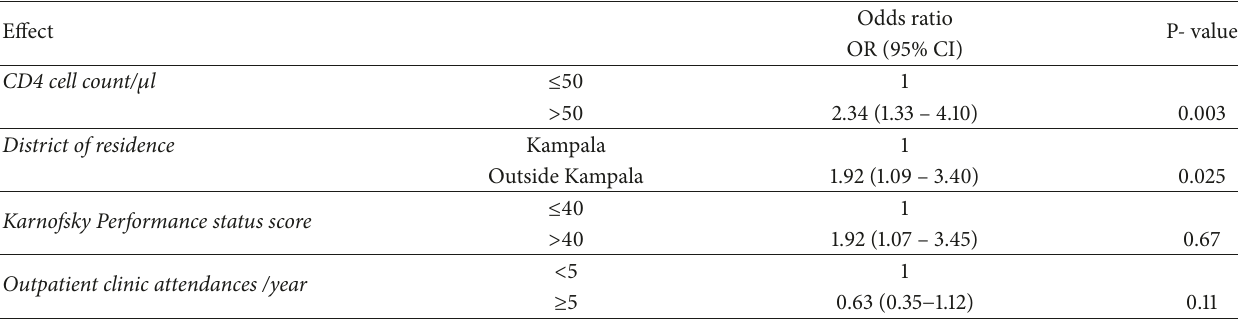
Table 2: Predictors of delayed initiation of cART among HIV-infected adults hospitalized at Mulago hospital.